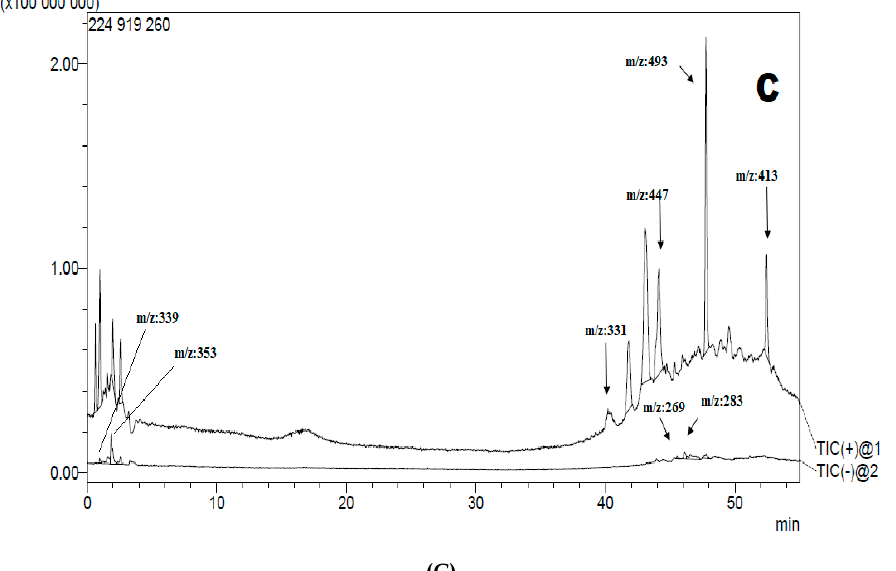
Figure 1. Total ion current (TIC) profile of AcDE ( A ) AcEAE ( B ) and AcBE ( C ).